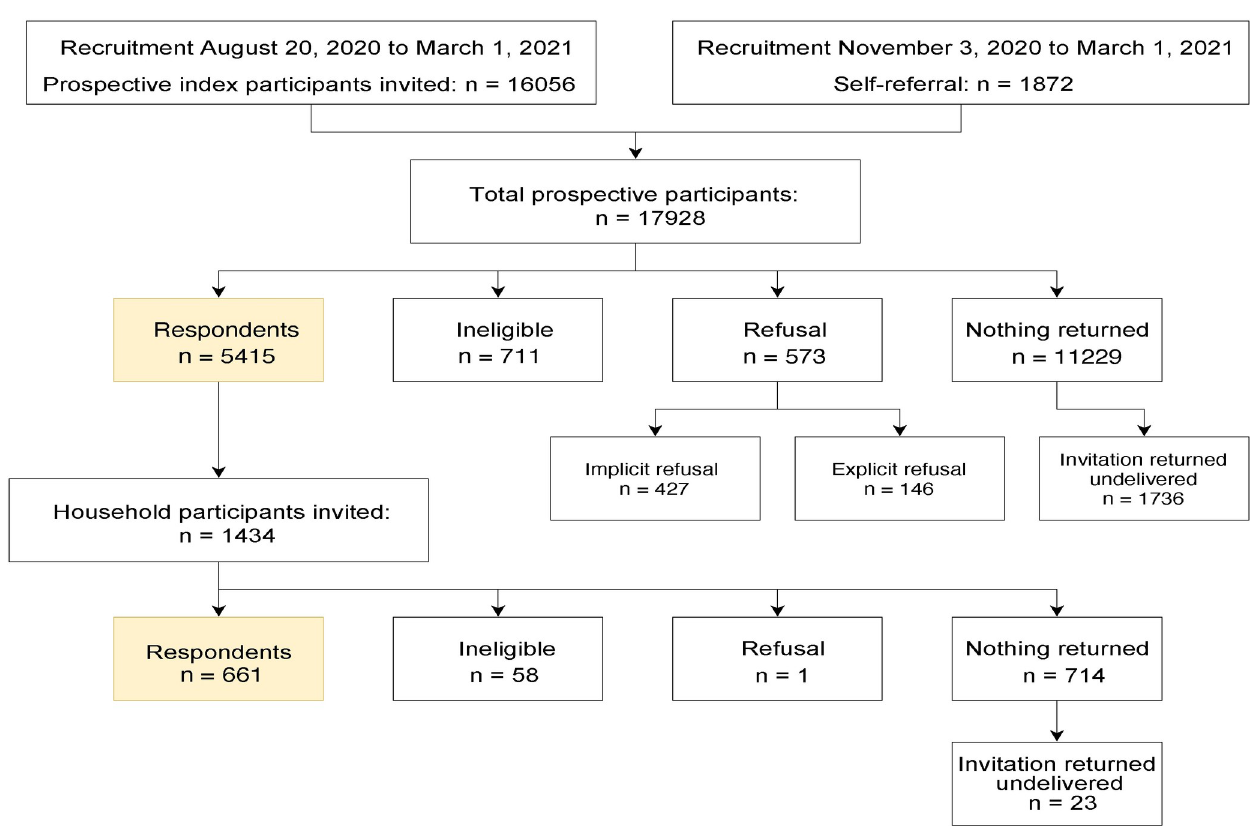
Fig 1. A flow diagram of prospective participants and respondents to the